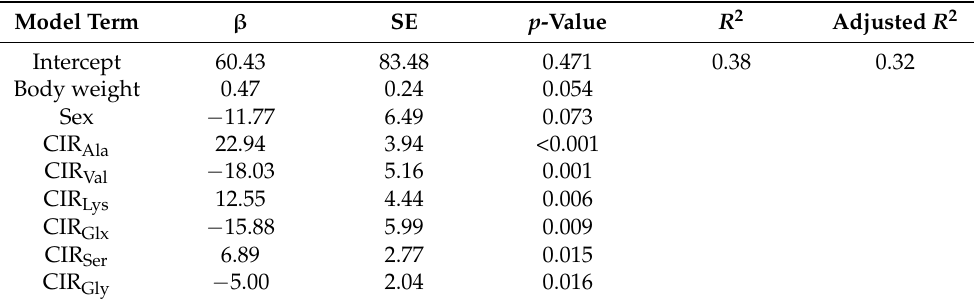
Table 4. Model of added sugar intake based on participant characteristics and serum CIR AA s in a controlled feeding study of men and women ( n =